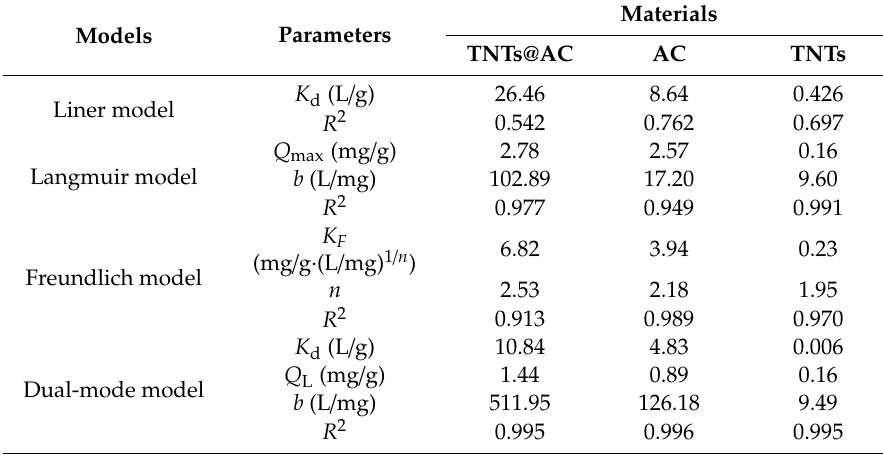
Table 1. Parameters of isotherm models for E2 (0.1−1.5 mg/L) adsorption onto various materials. Models